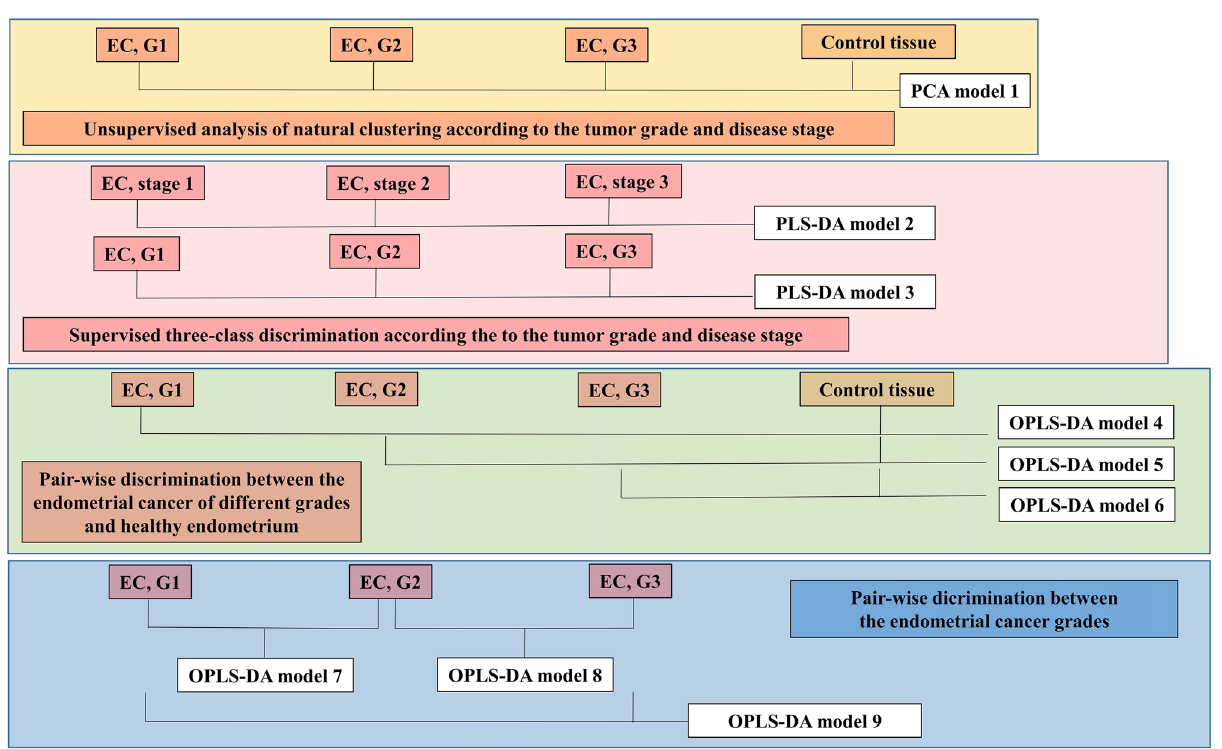
Figure 1. The scheme presenting the constructed multivariate